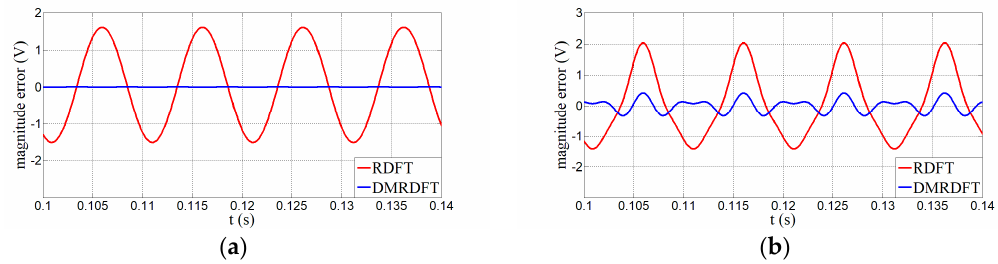
Figure 6. Steady performance comparison of grid voltage magnitude tracking: ( a ) performance when without harmonic, and ( b ) performance when with harmonic.